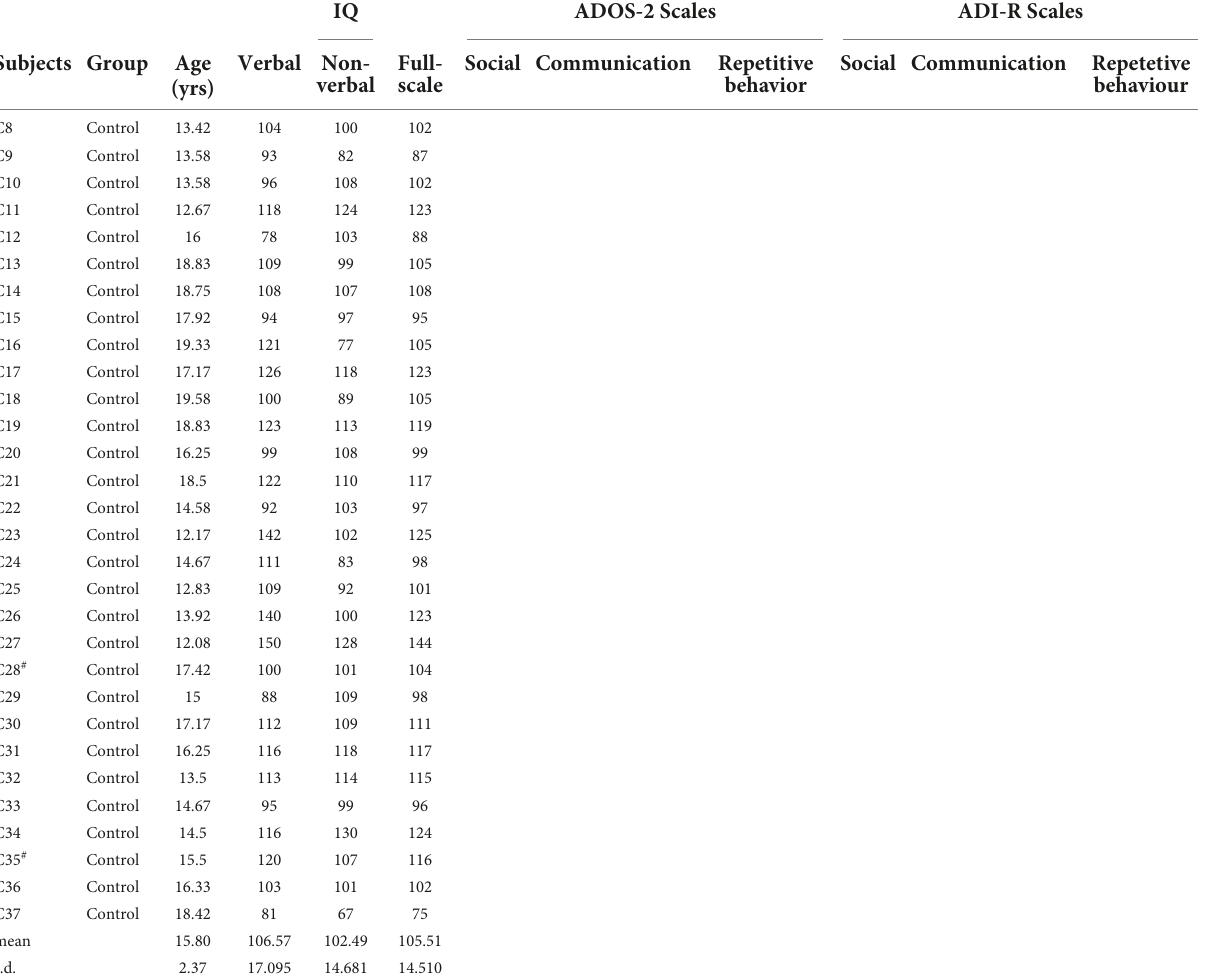
ADOS-2module3cutoffautismspectrumdiagnosis=7;ADOS-2module4cutoffASDdiagnosis=6. # GirlsASDgroup n =2,Controlgroup n =2. RT-reactiontime.